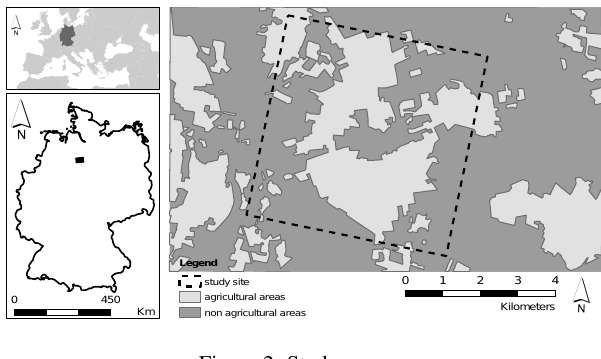
Figure 2. Study area.